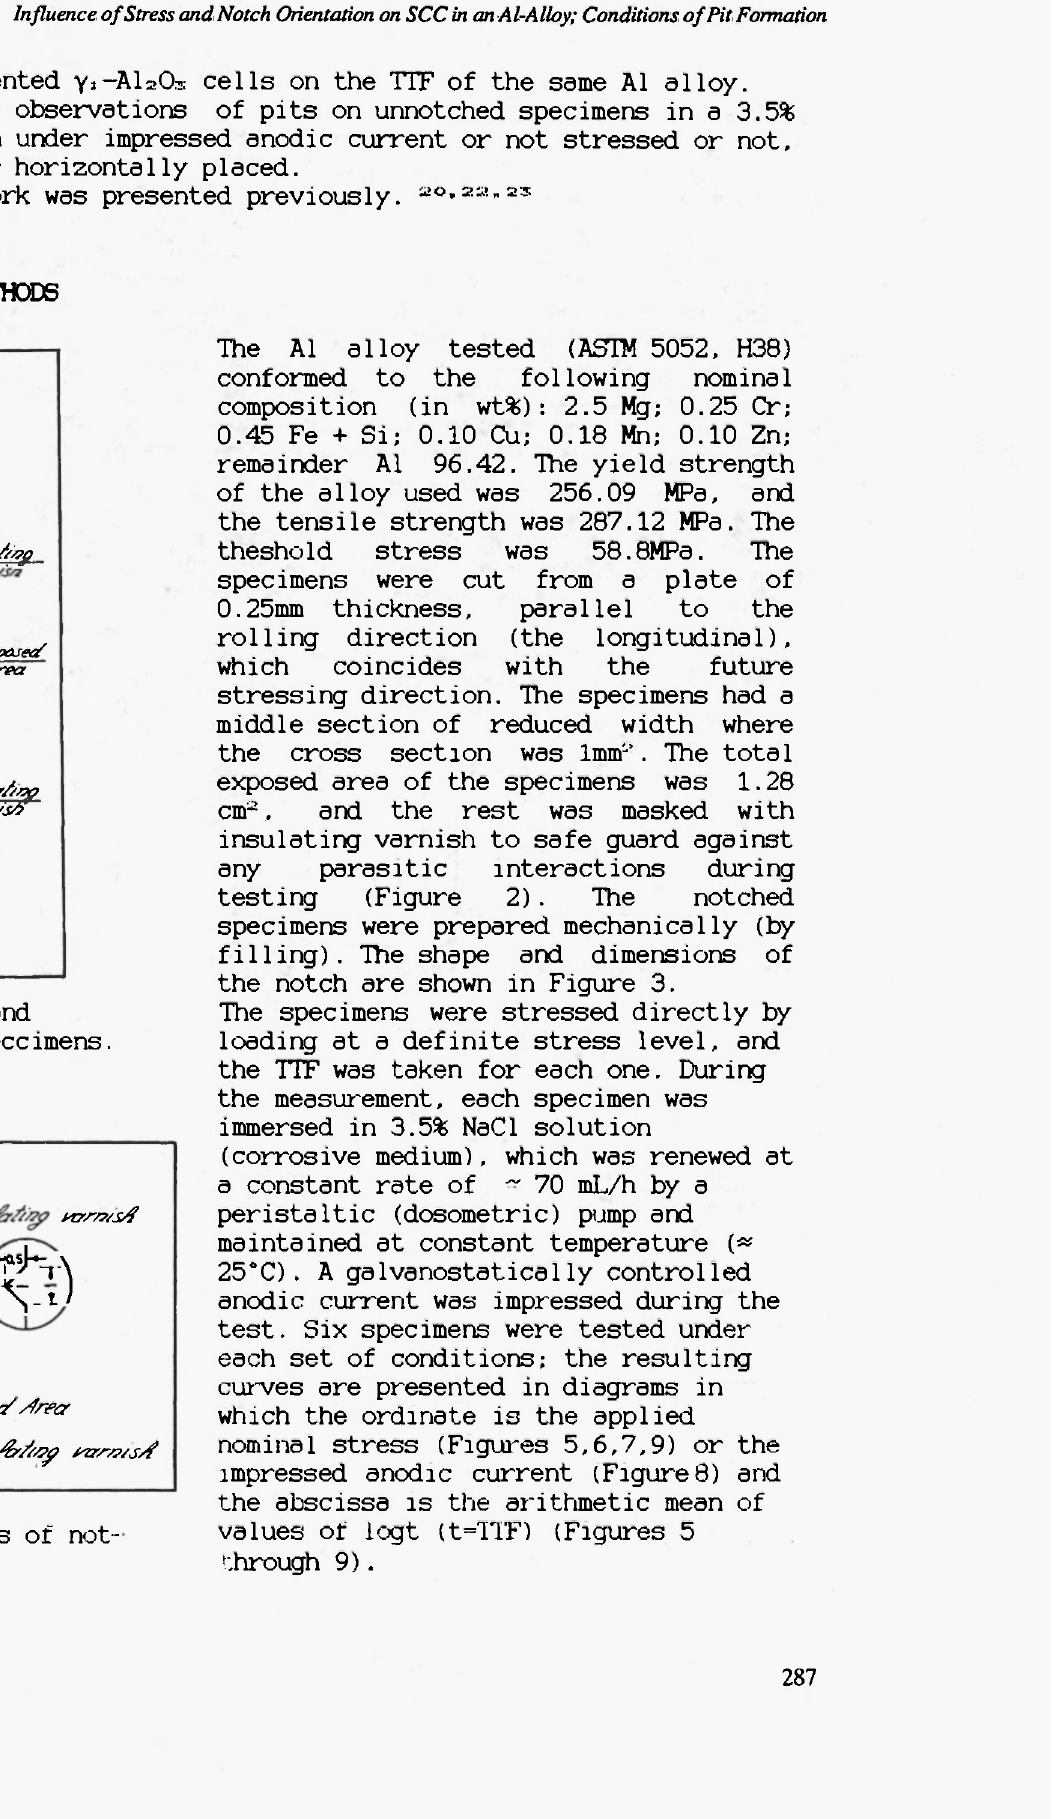
Figure 2. Shape and dimensions of speccimens.